Question: Produce a descriptive caption suitable for publication.
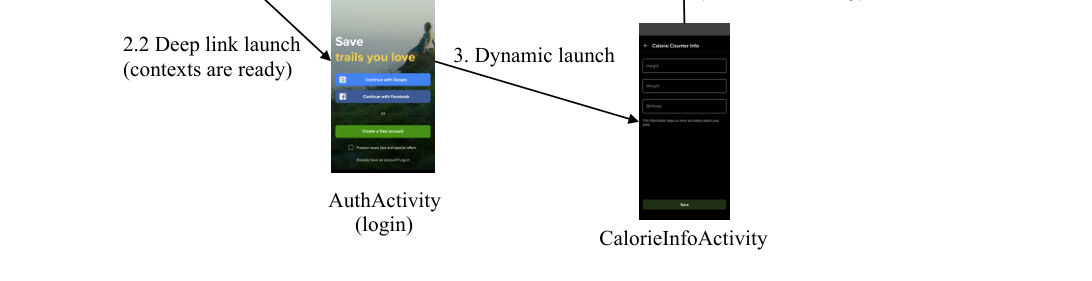
Answer: A concrete example of the enhancement exploration process in the app ‘Alltrails’.